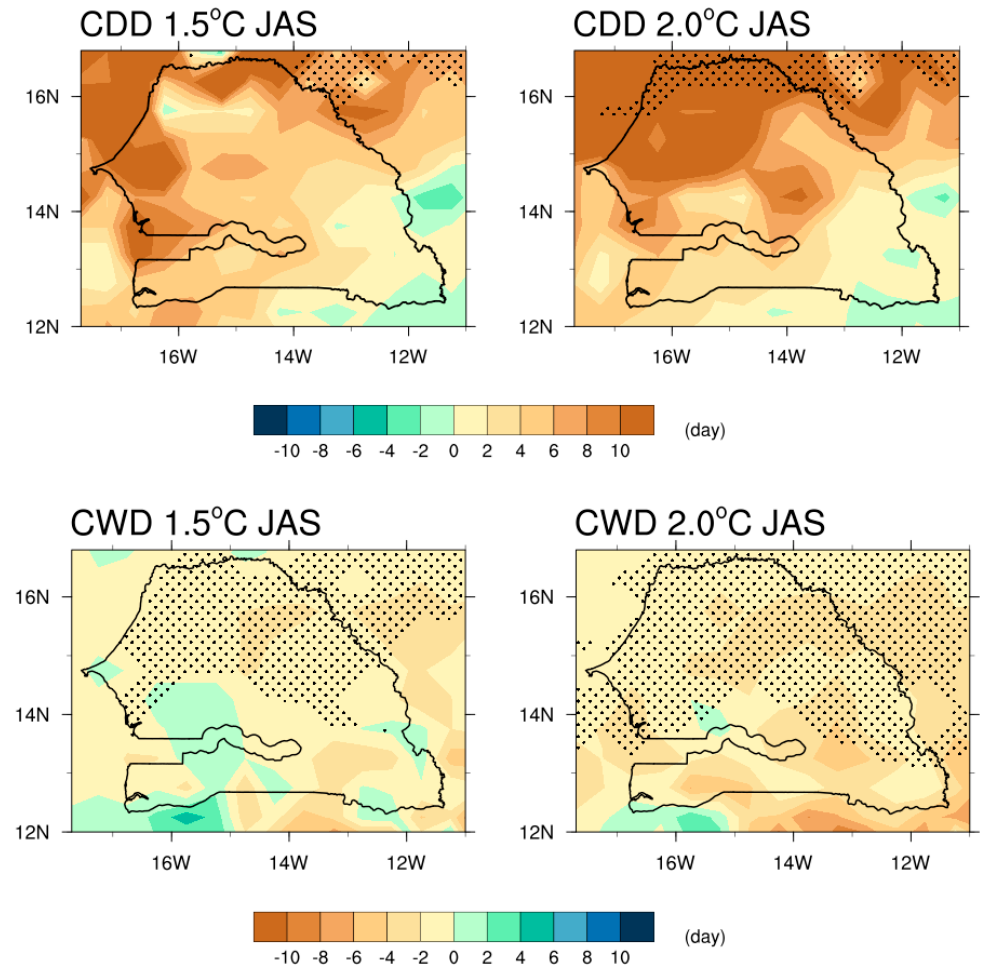
Figure 6. Maximum number of consecutive dry days (CDD) ( first row ) and maximum number of consecutive wet days (CWD) ( second row ) changes under 1.5 °C ( left column ) and 2.0°C ( right column ) GWLs. Statistically significant changes (Student’s t- test) at 95% confidence level are represented by black dots.